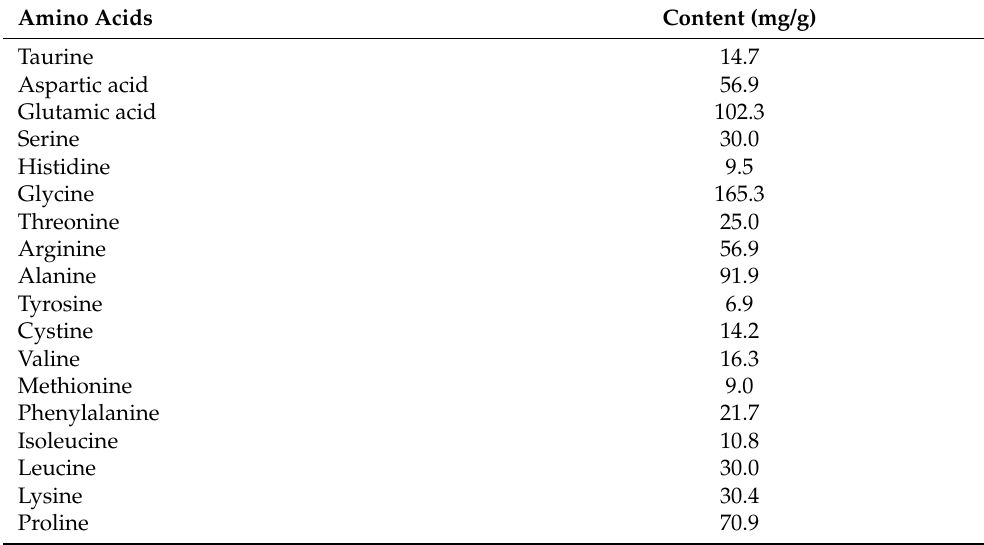
Table 1. Taurine and hydrolyzed amino acid profiles of hot water extract of tilapia